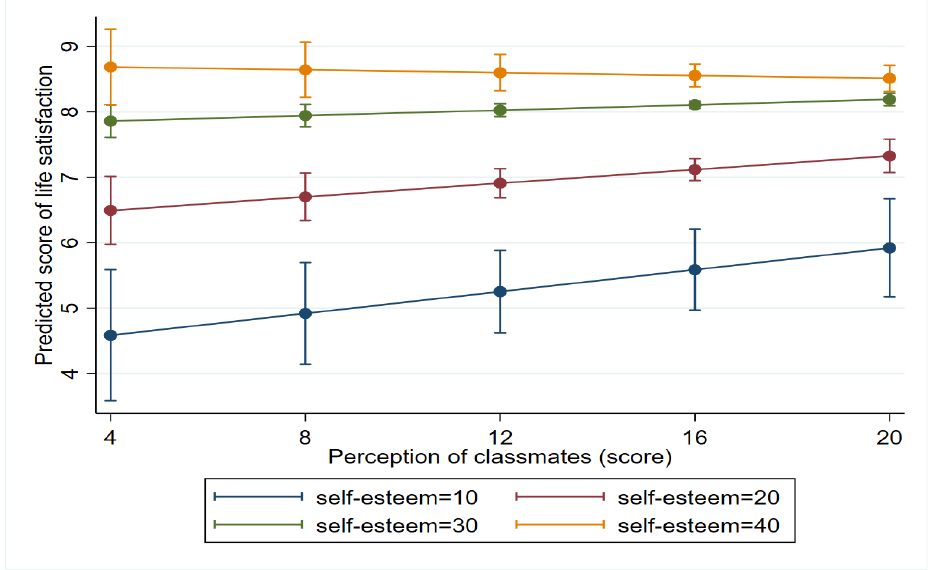
Figure 4. Marginal effects of the perception of classmates on life satisfaction at different levels of self-esteem.